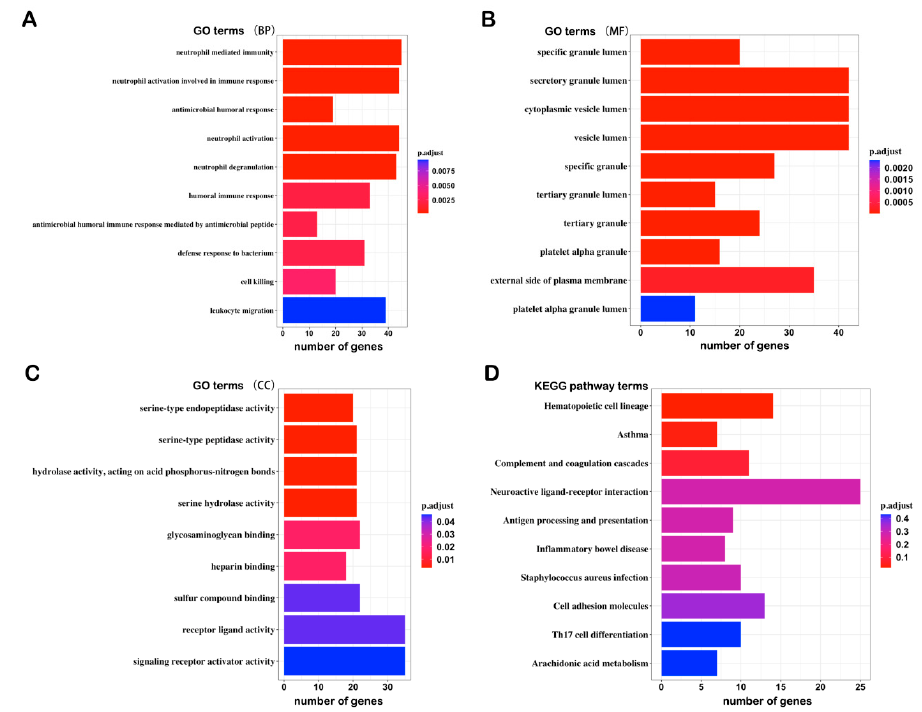
Figure 3. Top 10 GO and KEGG terms from the pathway enrichment analysis of the DEGs: ( A ) Biological process (BP); ( B ) molecular function (MF); ( C ) cellular component (CC); ( D ) KEGG pathway.